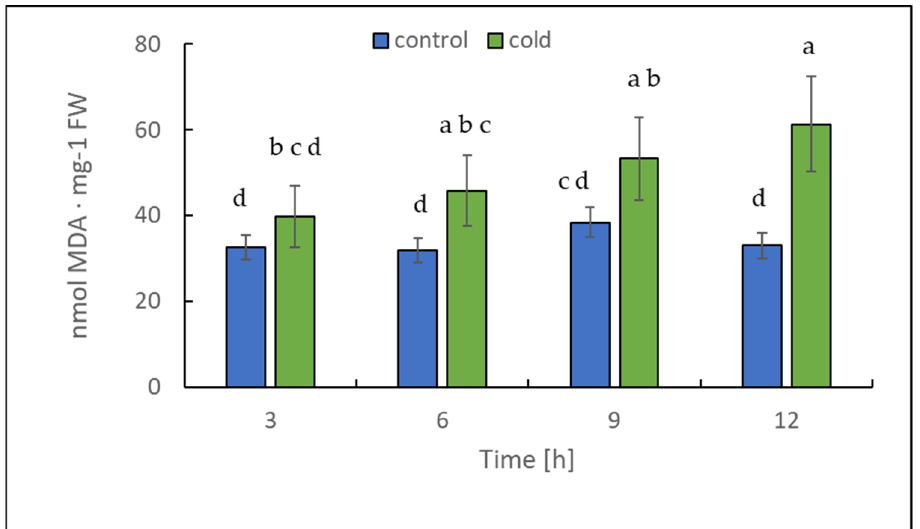
Figure 5. Malondialdehyde (MDA) content calculated on the basis of fresh weight (FW) in potato leaves growing under optimum conditions and exposed to low temperature. The results are the means of at least three biological replicates ± SD. Different letters at the top of the bars indicate significant differences, which were calculated ( p ≤ 0.05) according to the Tukey’s HD post hoc test.